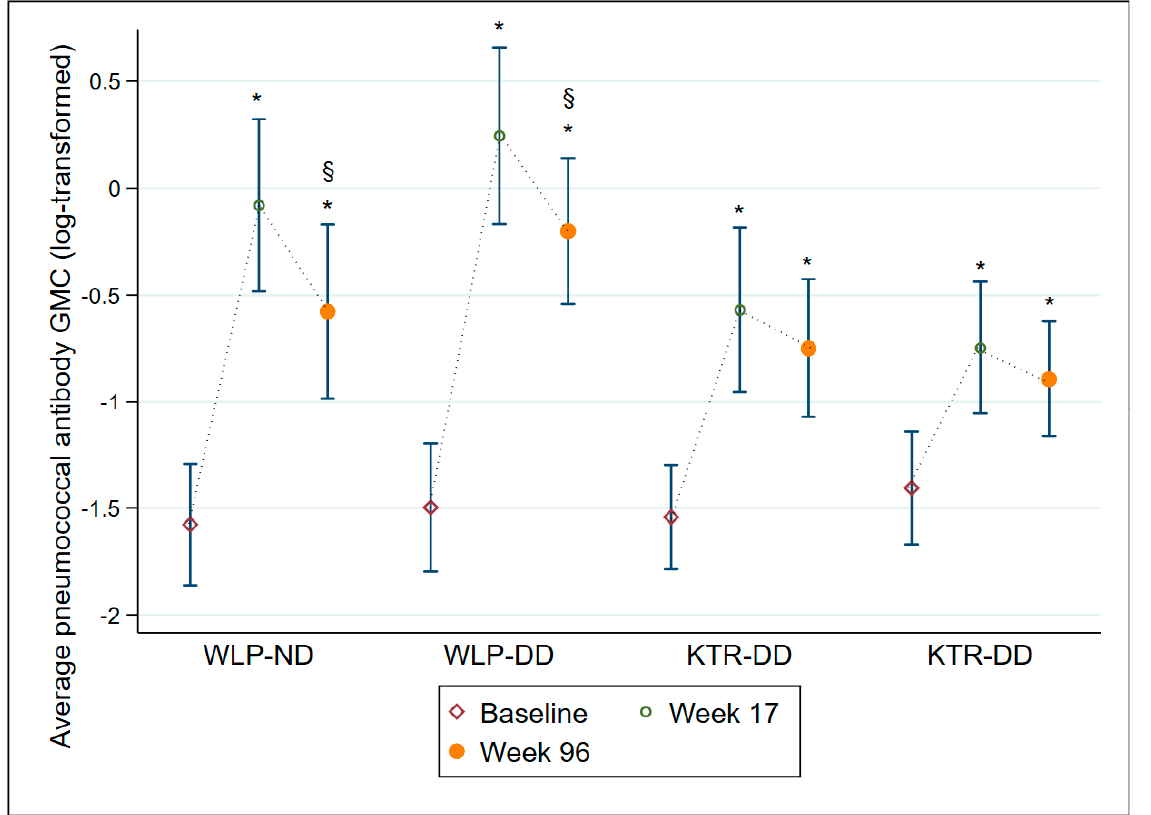
Figure 3. Average pneumococcal antibody geometric mean concentrations with 95% confidence intervals at baseline, week 17, and week 96 on a log-transformed scale for each of the 4